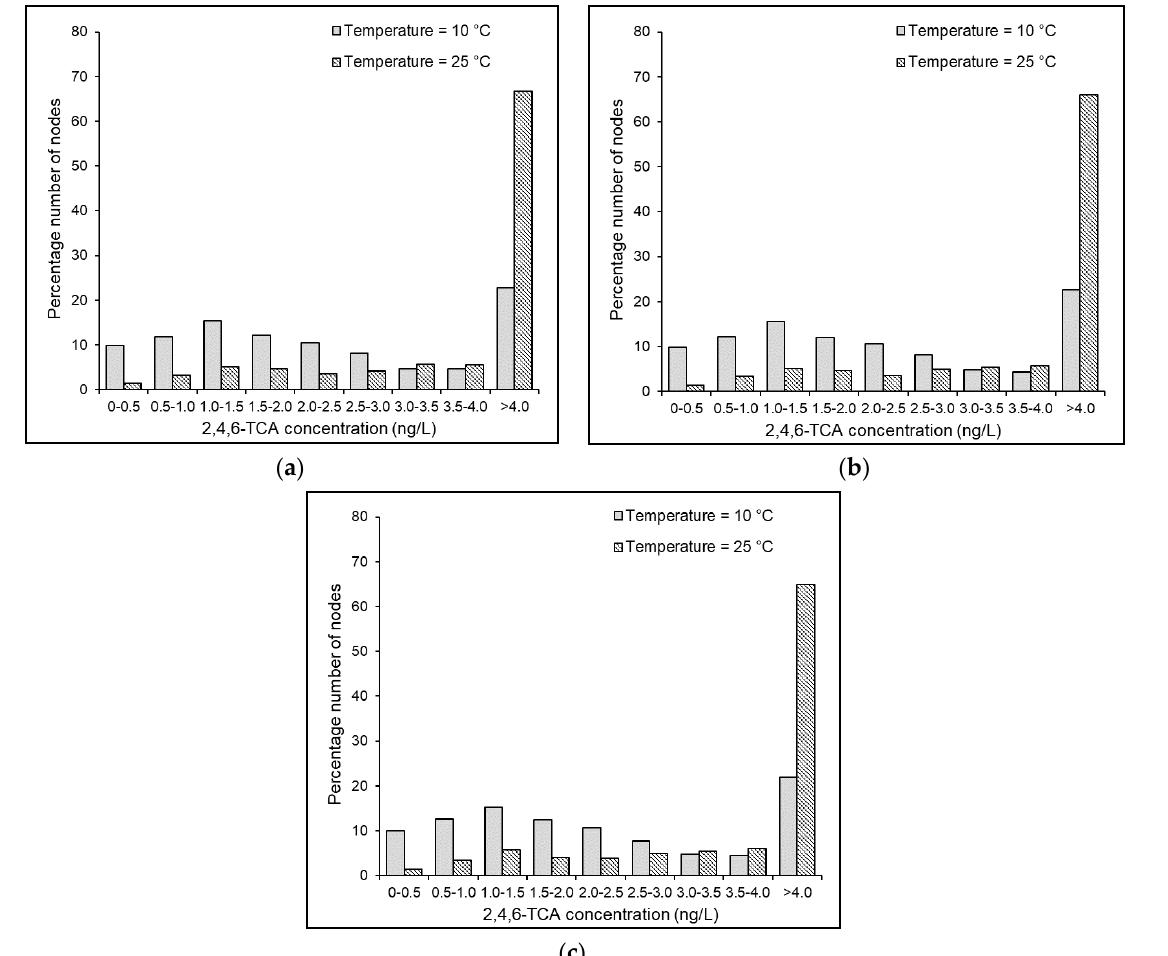
Figure 7. Predicted distribution of 2,4,6-TCA in the KLmod network under 𝑃 𝑜 = 0.2 mg/L, ( a ) non-chlorinated condition and 𝐶 𝑜 = ( a ) 0, ( b ) 0.5, and ( c ) 1.0 mg/L.